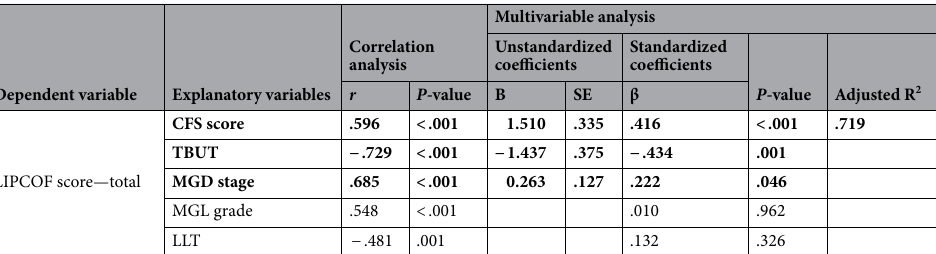
Table 2. Clinical parameters influencing severity of conjunctivochalasis in patients with dry eye disease . Significant values are presented in bold type. Each P- value was obtained via Spearman correlation analysis or stepwise multivariable regression analysis; r, Spearman’s correlation coefficient. SE, standard error; LIPCOF, Lid-parallel conjunctival folds; CFS, corneal and conjunctival fluorescein staining based on Oxford schema; TBUT, tear break-up time; MGD, Meibomian gland dysfunction; MGL, Meibomian gland loss; LLT, Lipid layer